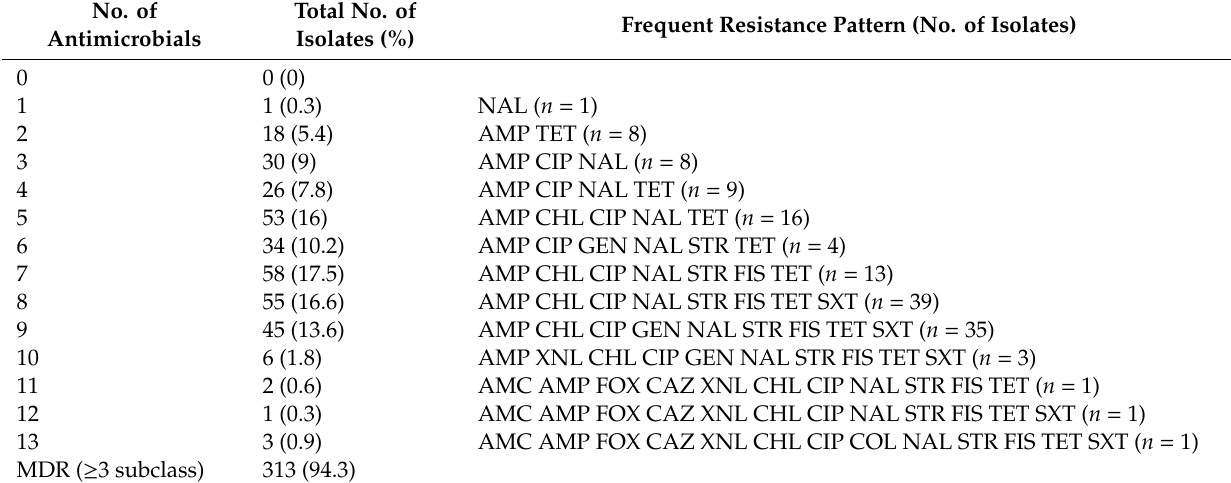
Table 2. Frequent antimicrobial resistance patterns of Escherichia coli isolated from healthy broiler chickens in Korea. No. of Total No. of Frequent Resistance Pattern (No. of Antimicrobials Isolates (%)